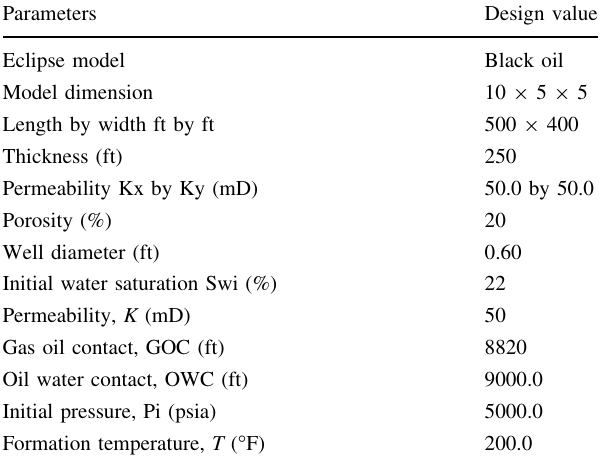
Table 4 Reservoir and fluid data